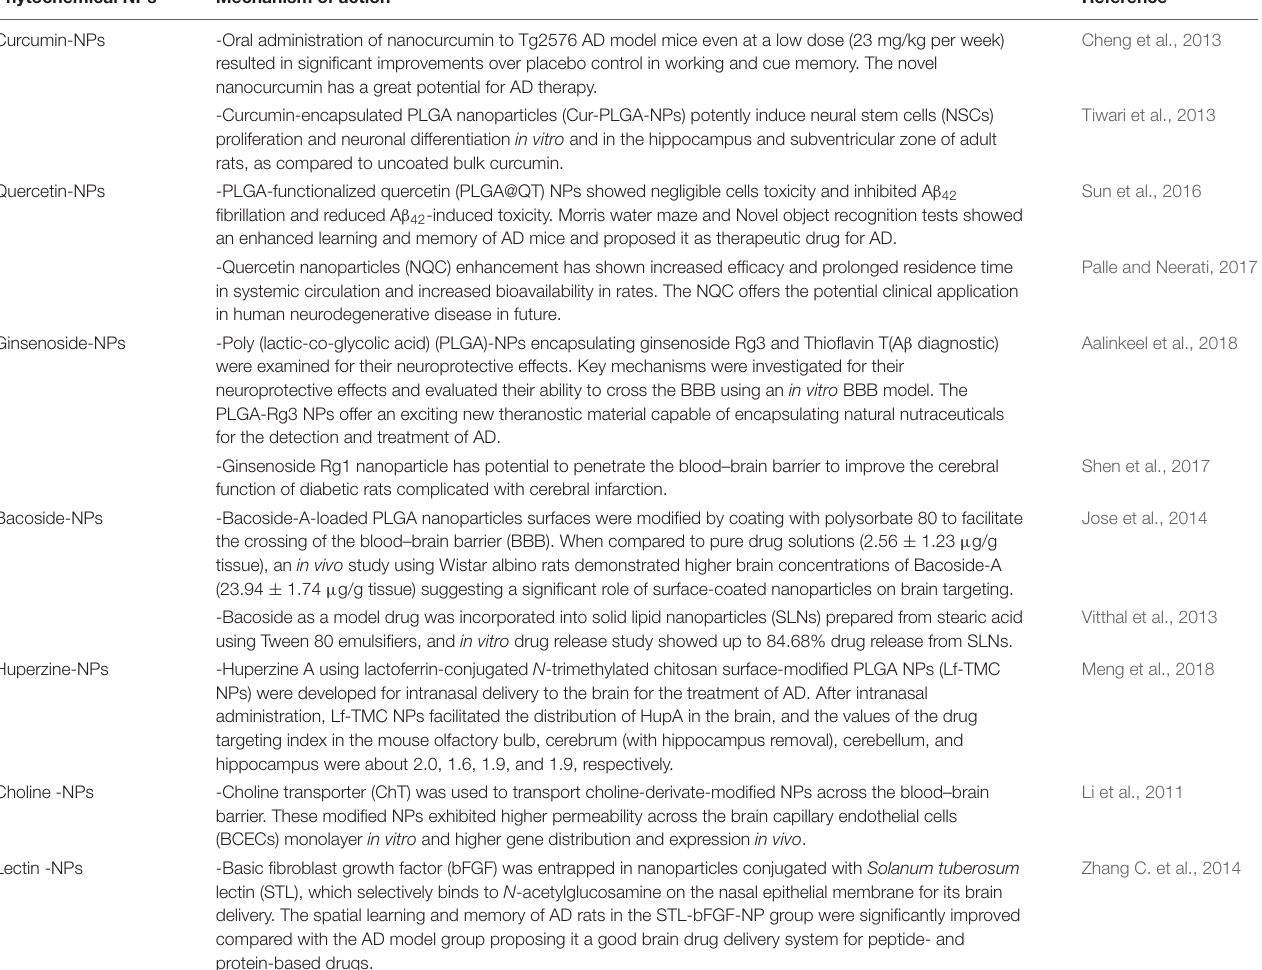
TABLE 3 | Phytochemicals used as drug delivery agents for synthesis of NPs in treatment of